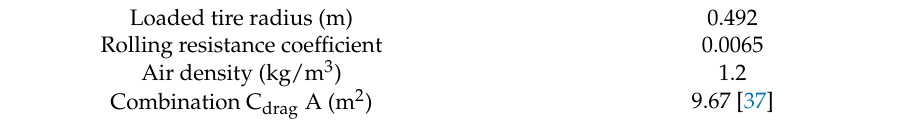
Table 3. Transmission